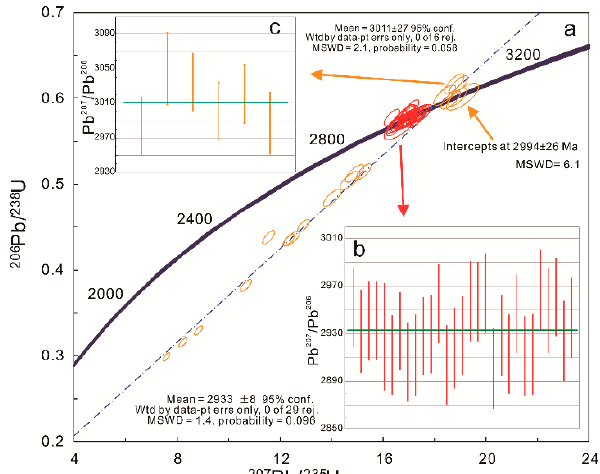
Figure 5. Zircon U–Pb age diagrams for the biotite–tremolite schist (D0002-1). ( a ) Orange circles for all analyzed spots ( n = 19) with a discordia curve that shows an upper intercept age of 2994 ± 26 Ma (MSWD = 6.1). Red circles for a concordia curve ( n = 29) yield an age of 2940 ± 19 Ma (MSWD = 0.42); ( b ) Weighted mean values for all spots with concordant ages ( n = 29). The mean age is 2933 ± 8 Ma (MSWD = 1.4); ( c ) Weighted mean values for six spots that yield a concordant age of 3011 ± 27 Ma (MSWD = 2.1).